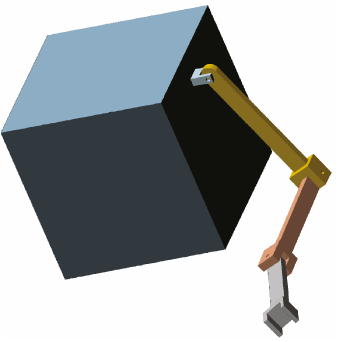
Figure 5: The Adams model of the single-arm three-link space robot at the fi nal con fi